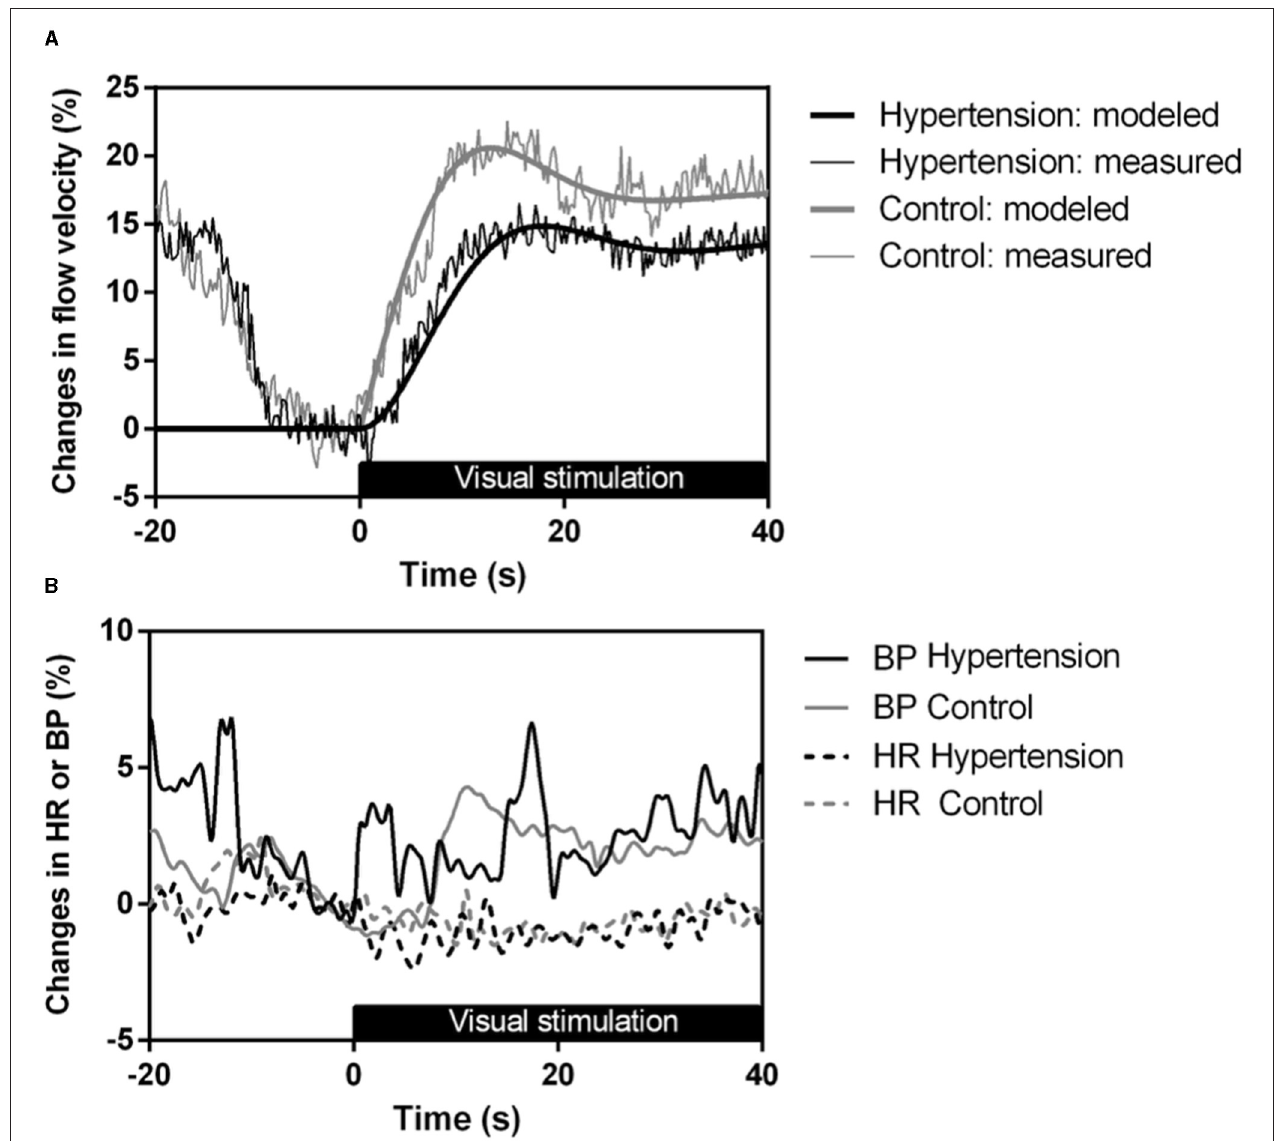
FIGURE 2 | (A) Group-averaged evoked systolic CBFV responses during visual stimulation with the flickering checkerboard; (B) Blood pressure (BP) and heart rate (HR) during visual stimulation with the flickering checkerboard. Gray lines represent healthy controls and black lines represent HT patients (thin lines: measured responses, thick lines: modeled blood flow